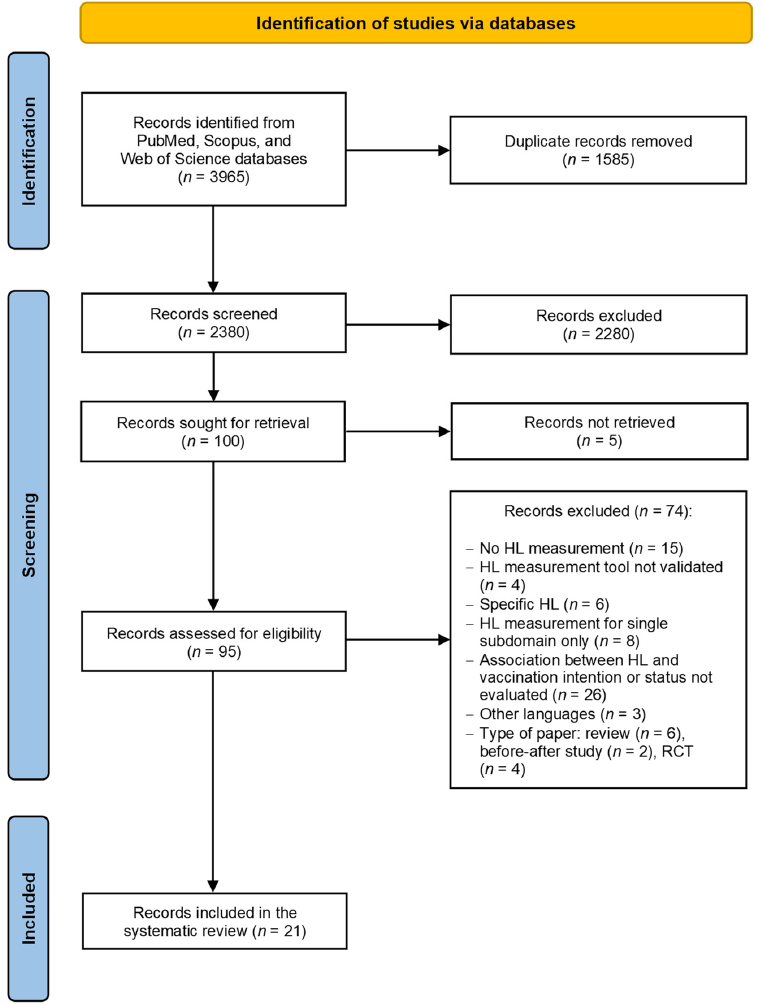
Figure 1. PRISMA flow diagram of the review process. HL: health literacy. RCT: randomized controlled trial. Table 1. Characteristics of the studies on intention to vaccinate included in the systematic